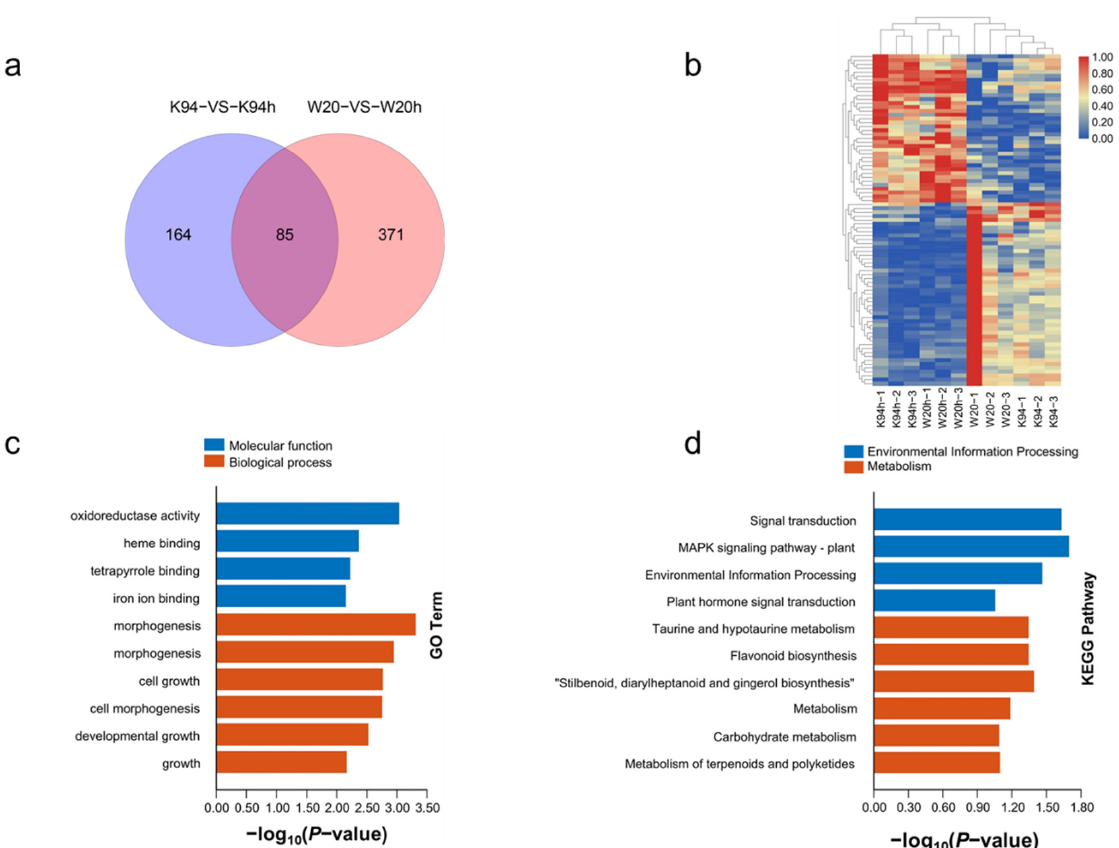
Figure 9. Identification of the functional annotation of DEGs between treatment and control samples, generated using high- throughput deep sequencing technology. ( a ) Venn diagram showing the number of overlapping DEGs in the experimental comparison between W20 and K94 varieties. ( b ) Clustering analysis of overlapping DEGs. The scale bar indicates upregulated (red) and downregulated (blue) DEGs. The darker the color, the higher the expression; the lighter the color, the lower the expression. ( c ) Top three GO classifications of overlapping DEGs in cannabis. ( d ) The top 10 enriched KEGG pathways of all the overlapping